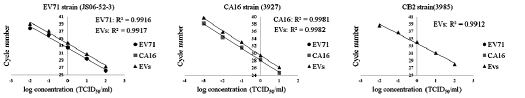
Figure 2. Quantitative analysis of the triplex RT-PCR for detecting EV71, CA16 and EVs- CB2.